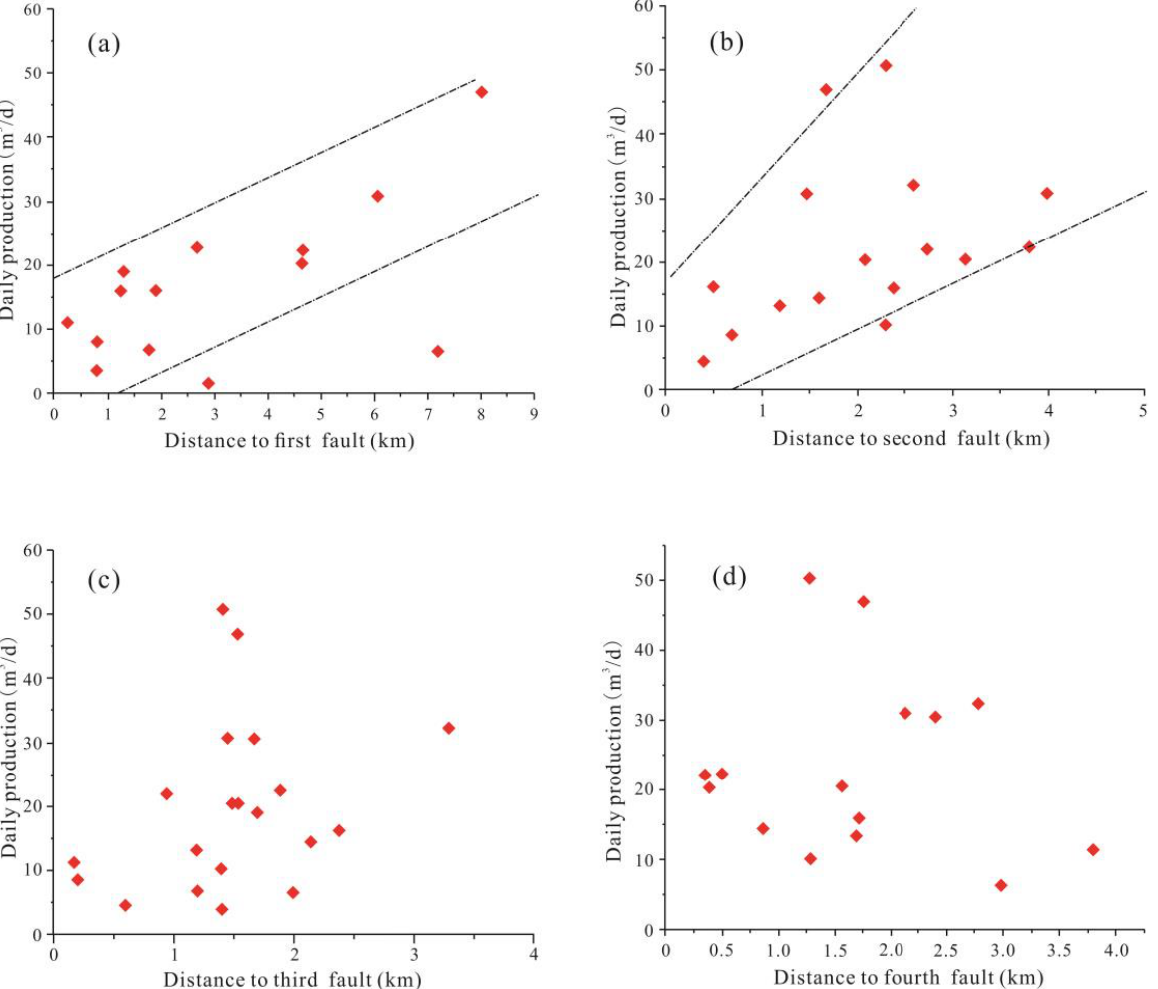
Figure 12. The relationship between the daily production and different level faults in the Luzhou area ( a ). Relationship between the daily production and first level faults ( b ); relationship between the daily production and second level faults ( c ); relationship between the daily production and third level faults ( d ).